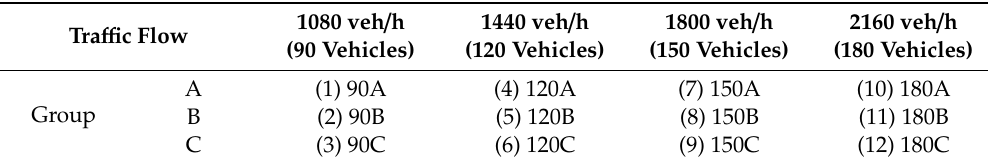
Table 4. Code names for 12 test scenarios.